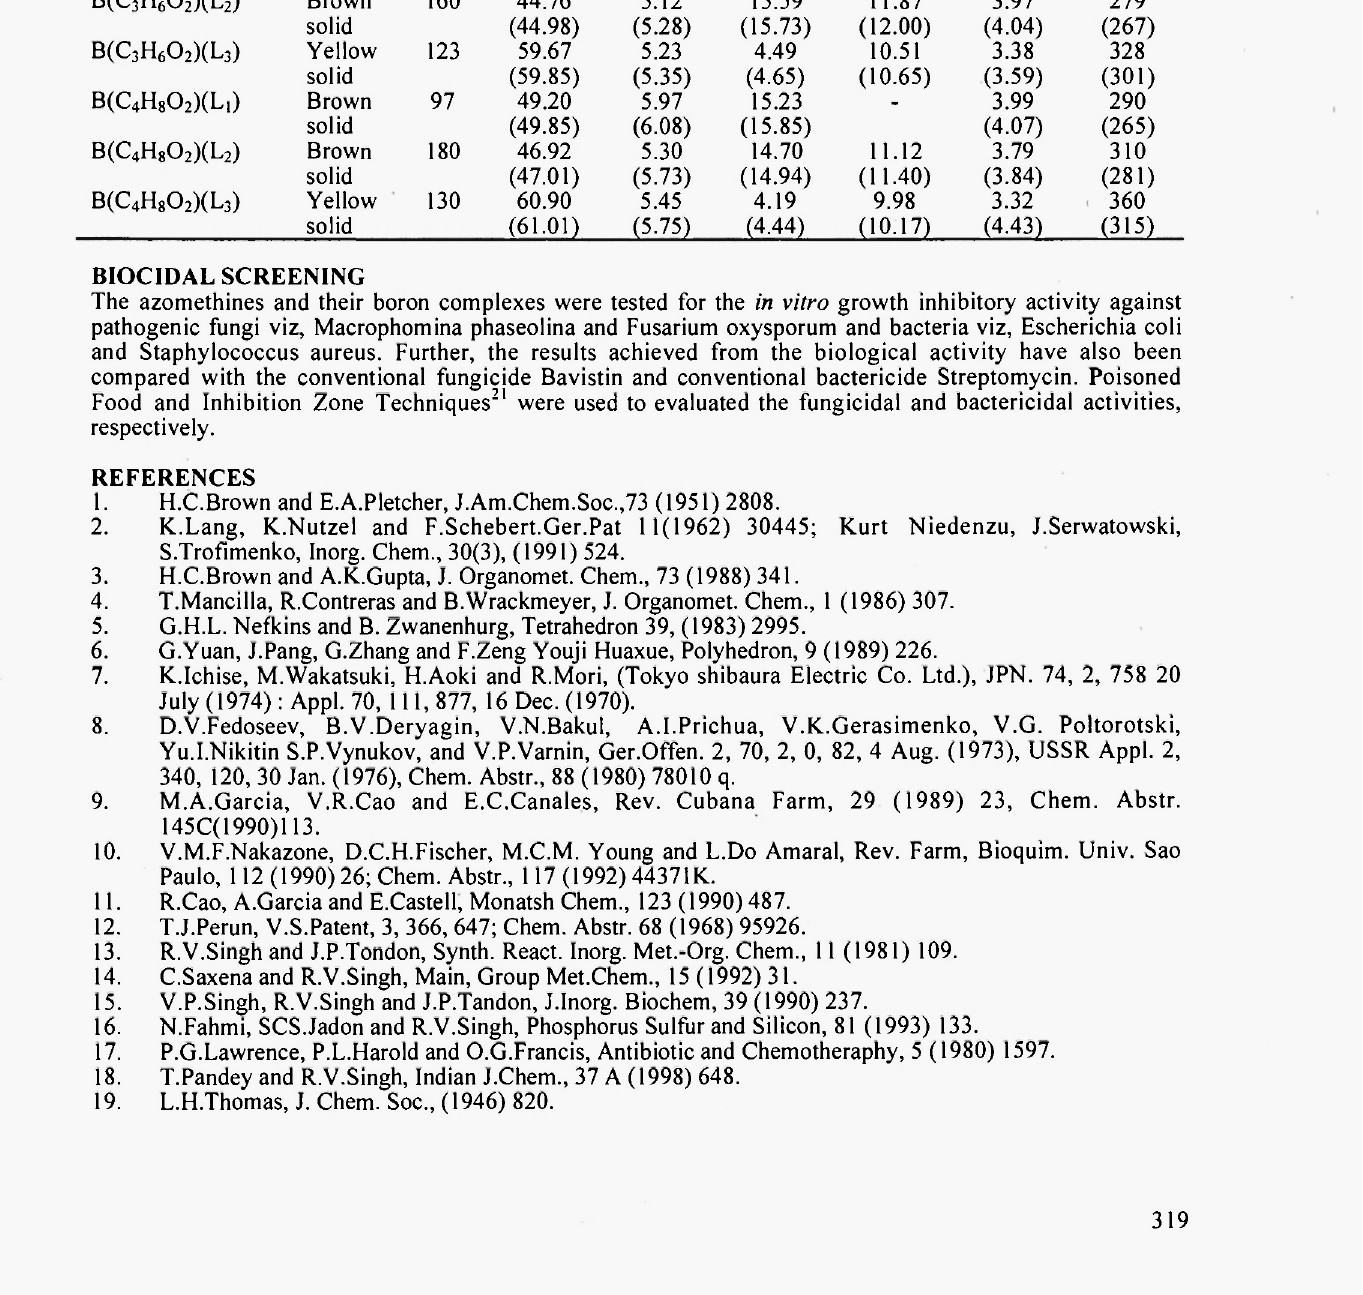
Table VI : Physical Properties and Analytical Data of Boron Complexes.